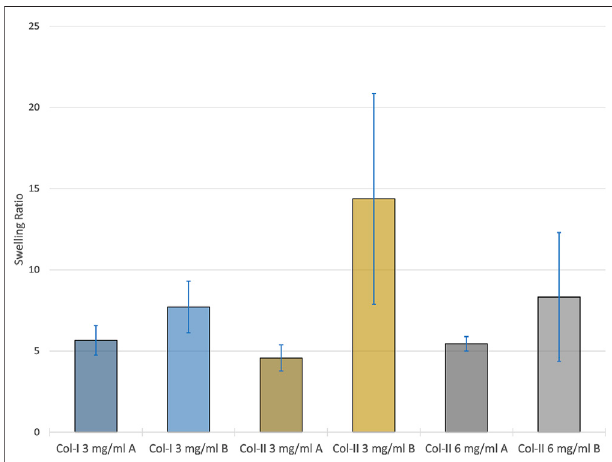
FIGURE 7 | The average swelling ratio of each samples group with error bars representing the standard deviation within each